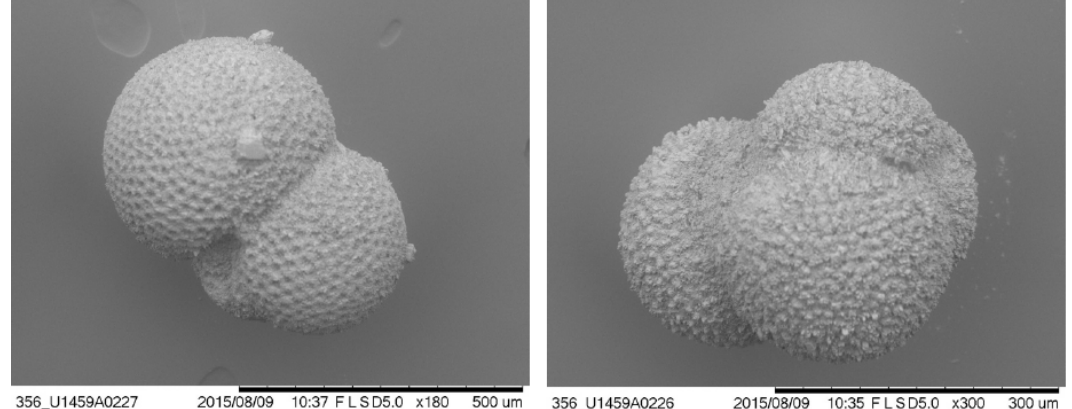
Figure C1. Representative SEM images of T. sacculifer in sample U1459A 9FCC 9–24cm, illustrating their preservation (Gallagher et al., 2017).